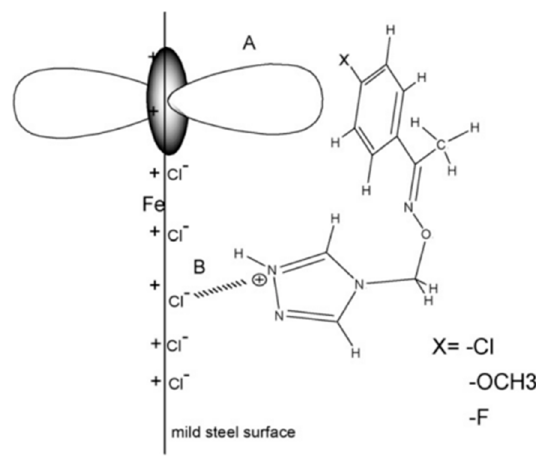
Figure 7. The schematic illustration of the adsorption behavior of the triazole derivatives on mild steel in 1 M HCl solution: ( A ) chemisorption and ( B ) physisorption steel in 1 M HCl solution: ( A ) chemisorption and ( B ) physisorption [72]. Vidhya [73] explained the corrosion inhibition performance of halogen-substituted pyridine derivatives through the DFT and the electron charge on the chelating atom. Com-